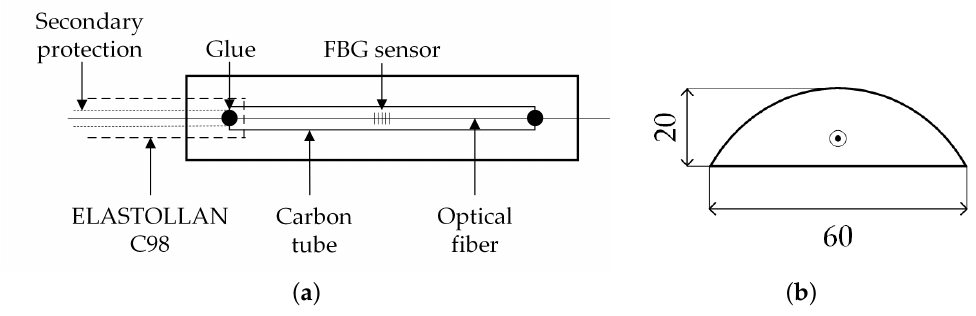
Figure 2. Structure of the portable sensor for monitoring density of automobile traffic density: ( a ) longitudinal section; and ( b ) cross-section.